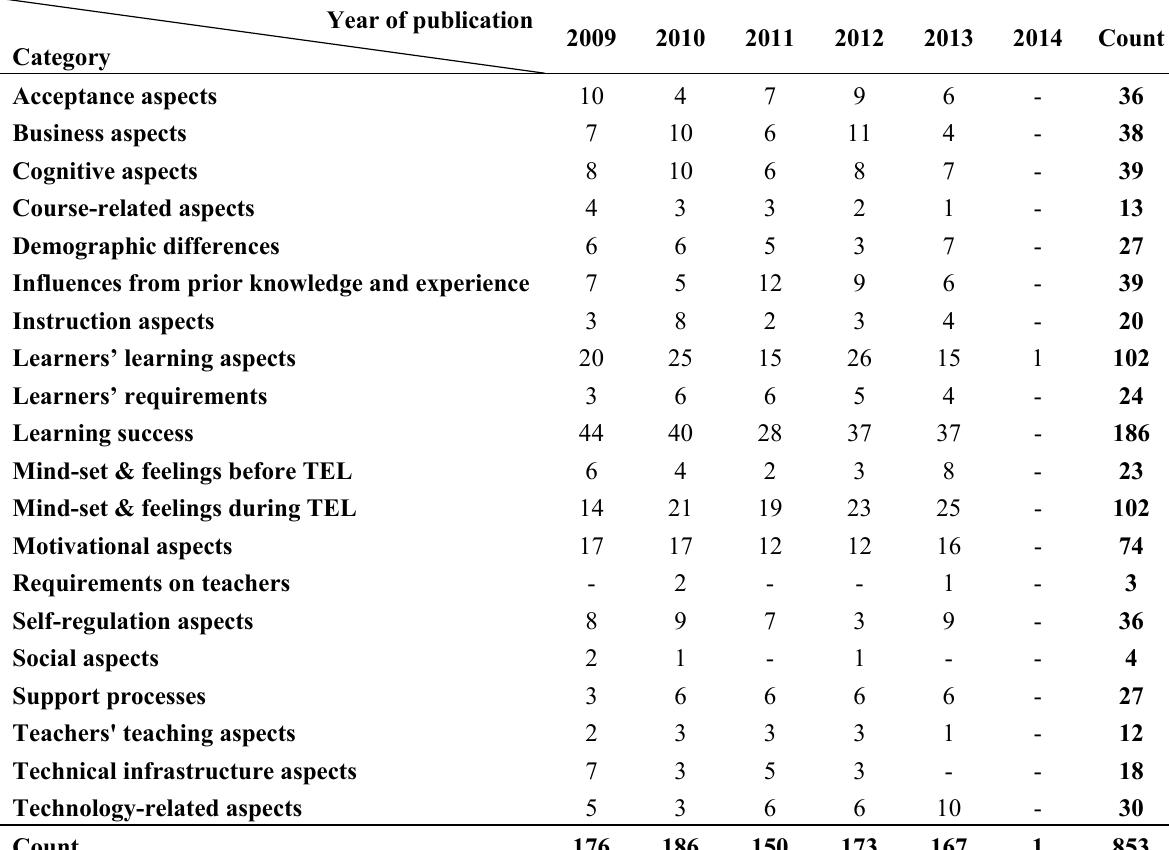
Table 2. Identified categories of aspects per year of